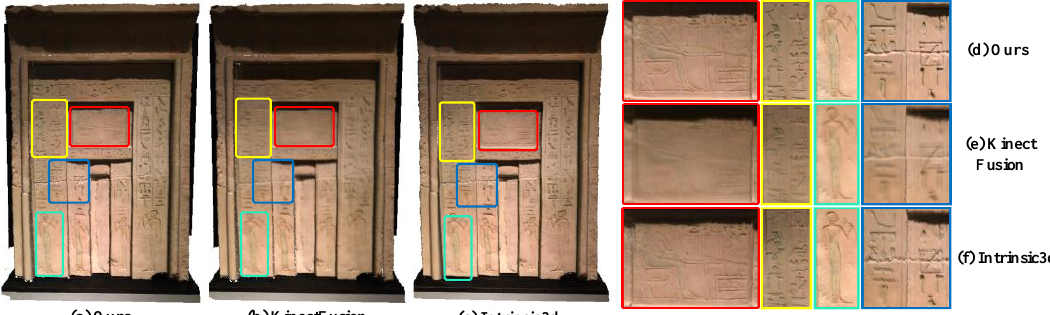
Figure 2. Texture reconstruction results of the Gate dataset. Our method ( a , d ) can achieve better results than the classical weighted average fusion method [6] ( b , e ) and the off-line Intrinsic3d reconstruction method [5] ( c , f ) in texture clarity.